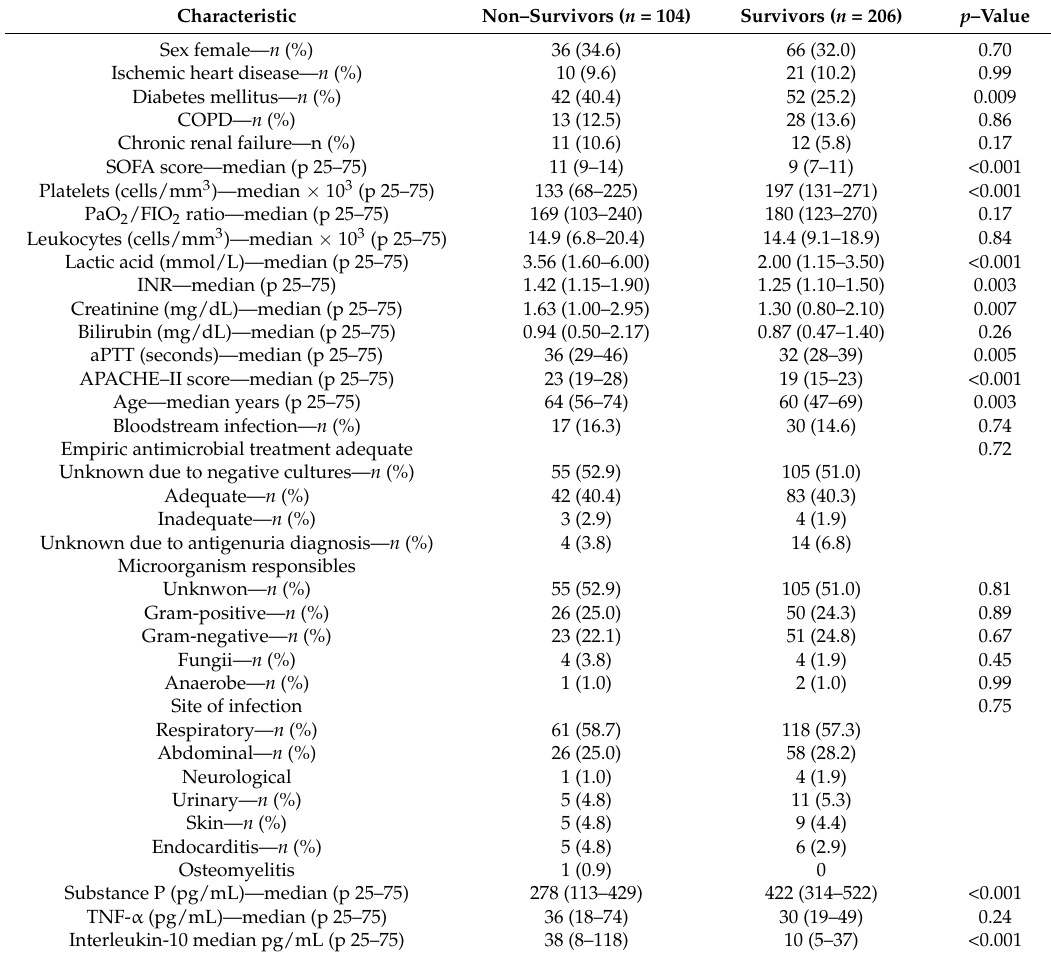
Table 1. Comparisons between non-survivor and survivor severe septic patients on demographic and clinical characteristics at the time of severe sepsis diagnosis.